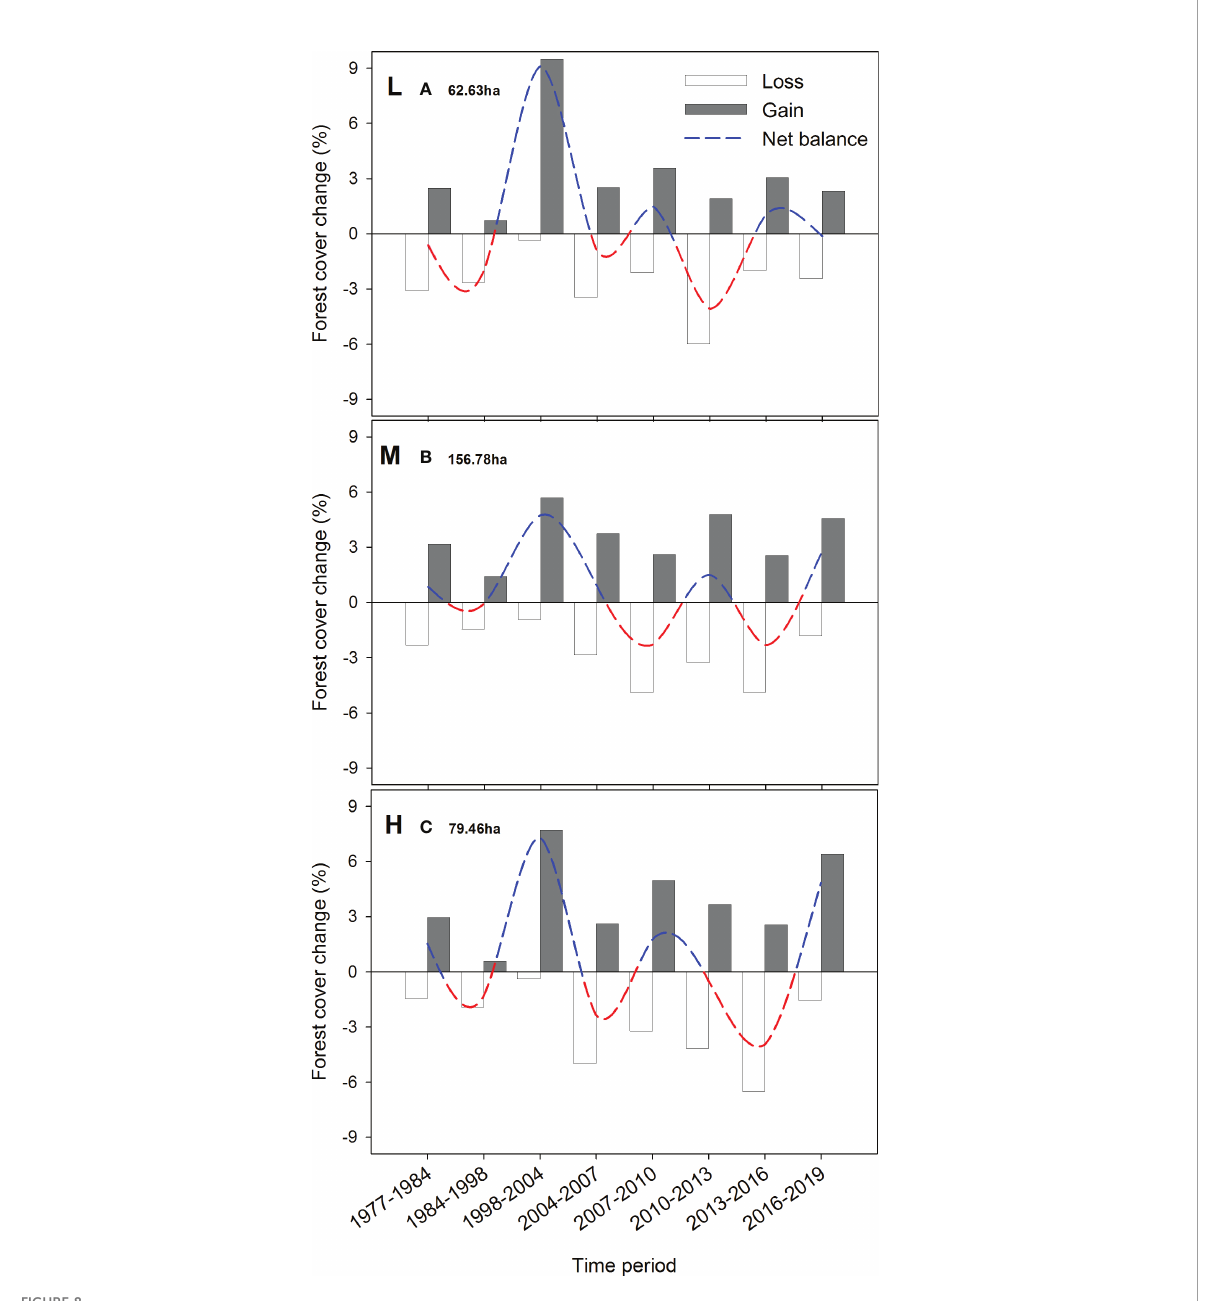
FIGURE 8 Annual rate of forest cover change is estimated as the loss (empty bars) and gain (gray bars) of forest surface (ha) between the dates of sequential aerial orthophotographs, divided by the number of years included in that period. The net balance was estimated as the difference between gains and losses in each period, depicting forest surface increases (blue dashed line) or decreases (red dashed line). Estimates were performed for low (880-1150 m a.s.l.; graph A ), mid (1150-1350 m a.s.l.; graph B ), and high (1350-1550 m a.s.l.; graph C ) altitudinal bands. The total area (ha) for each band is also shown to understand the scale of the forest cover